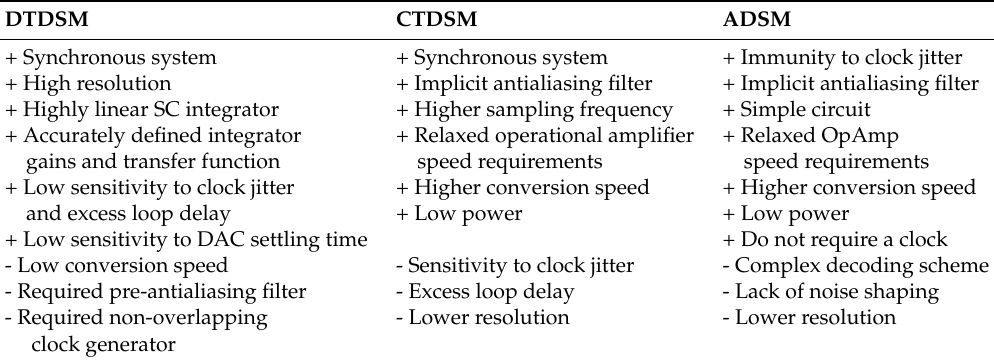
Figure 1. Voltage and frequency ranges of some common biopotential signals. Table 1. Comparison between DTDSM, CTDSM, and